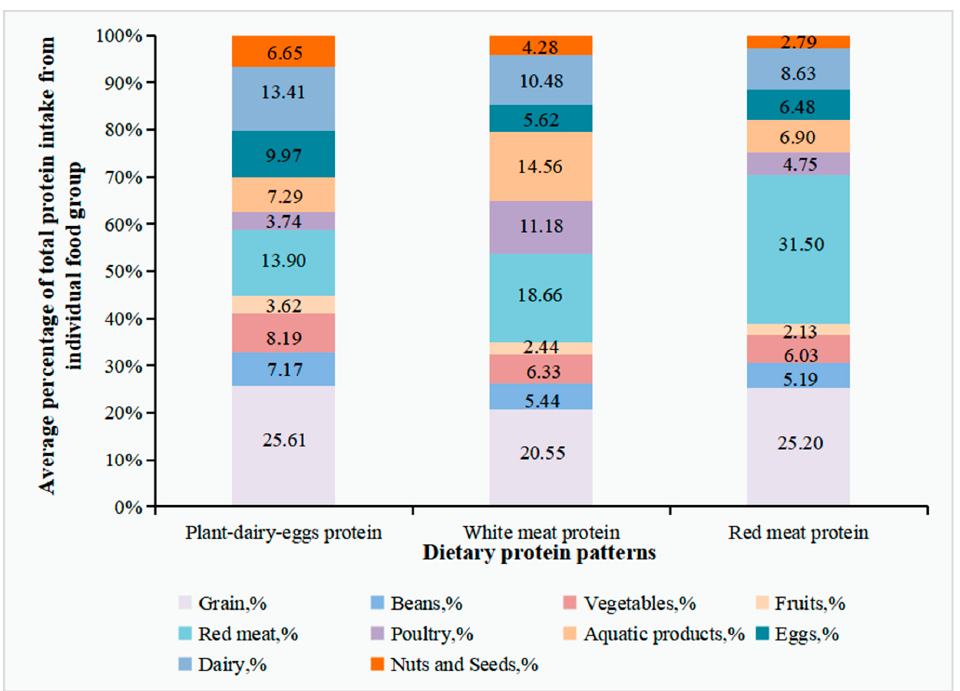
Figure 1. Average percentage of total dietary protein intake from individual food groups across the protein food cluster analysis. A K-means cluster analysis was performed to categorize subjects into mutually exclusive groups. The name of the clusters was determined according to the percentage that represented the highest consumption of one or two food groups. Percentage of total protein intake across each food group was used.The analysis of variance showed that there were significant differences among the percentage contributions of protein intake from each food group in the three dietary pattern groups ( p < 0.05) (Supplemental Table S2).